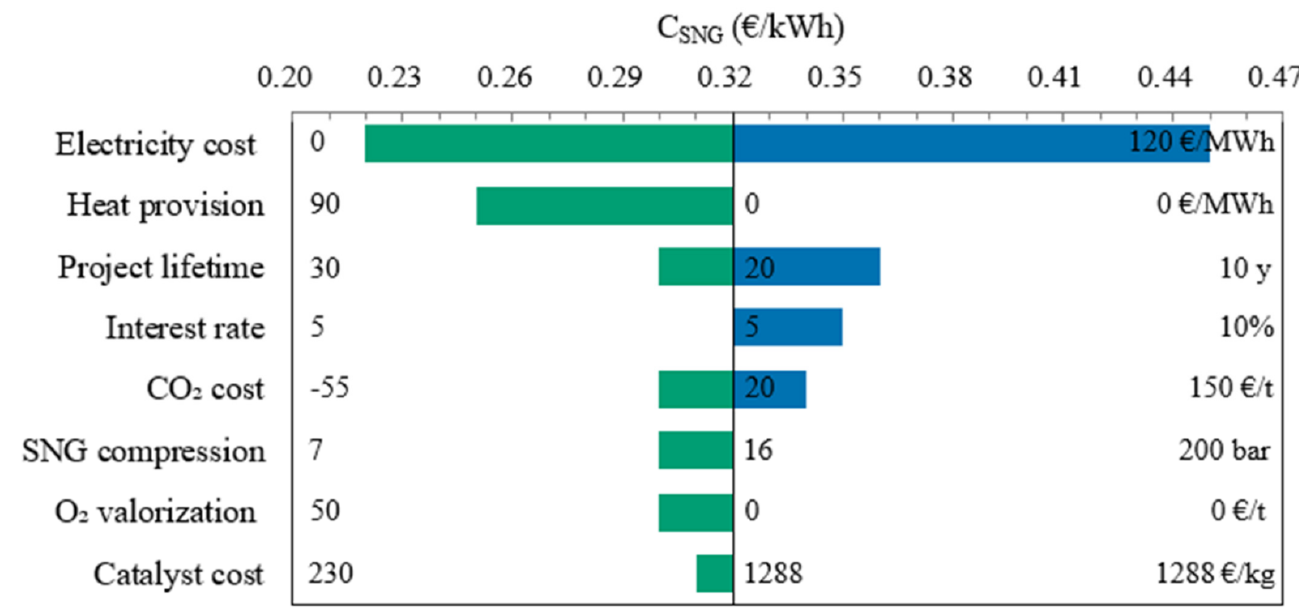
Figure 11. Sensitivity analysis of the PtSNG plant’s Reference